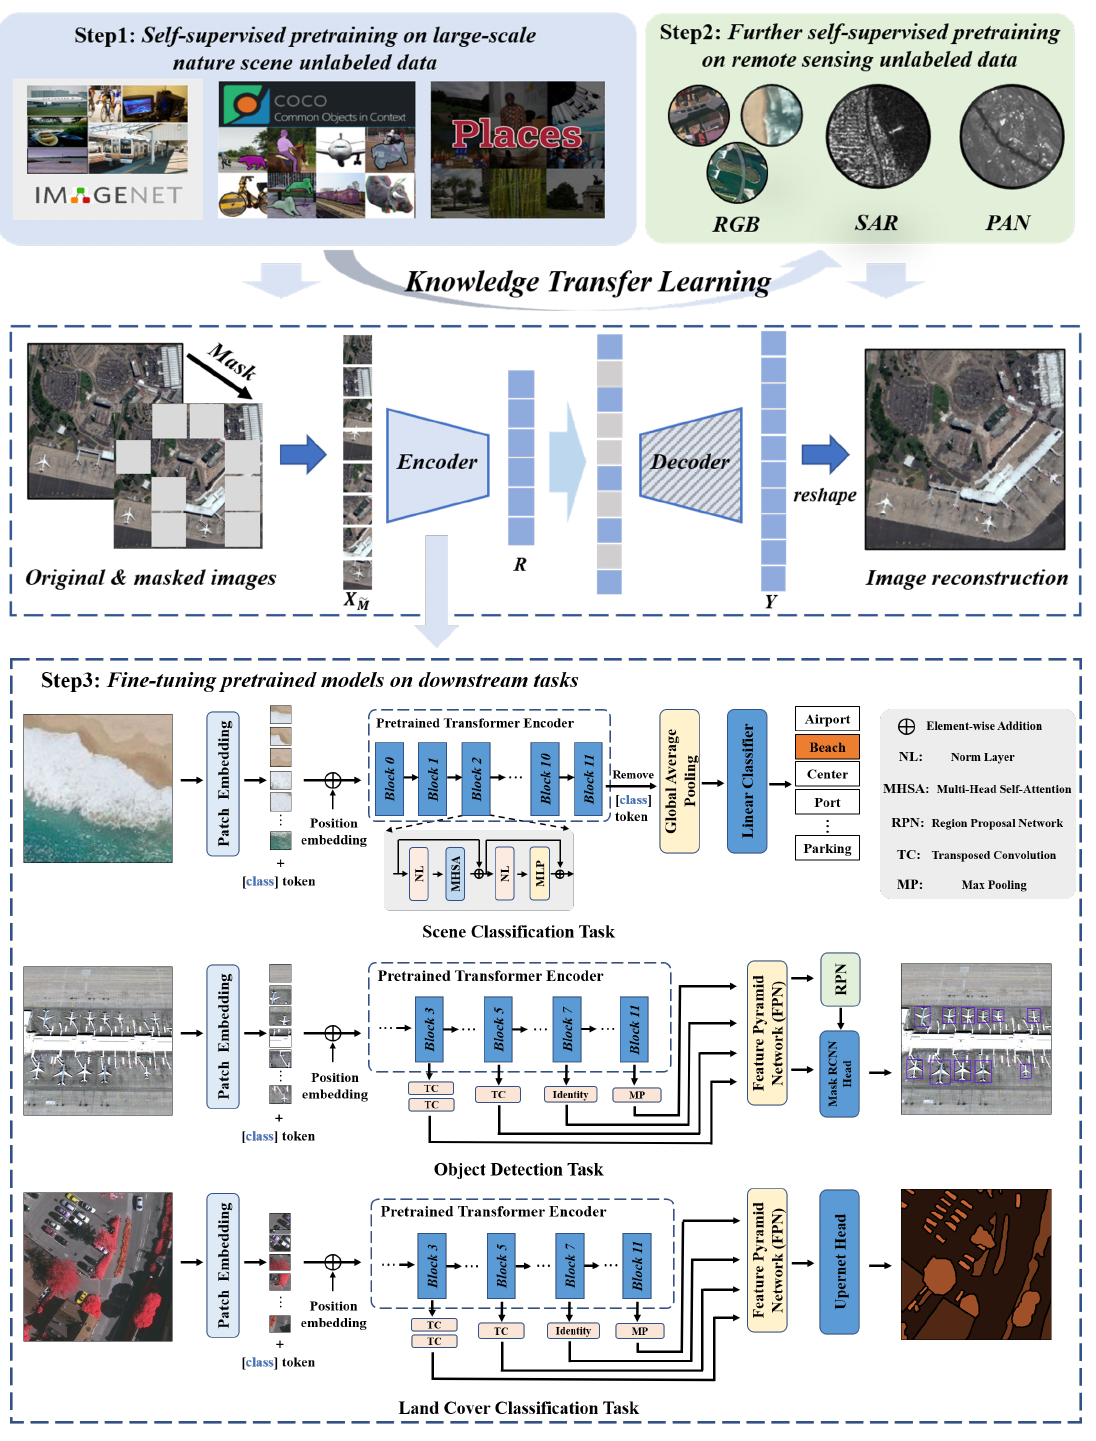
Figure 2. The knowledge transfer learning based model training process of our proposed